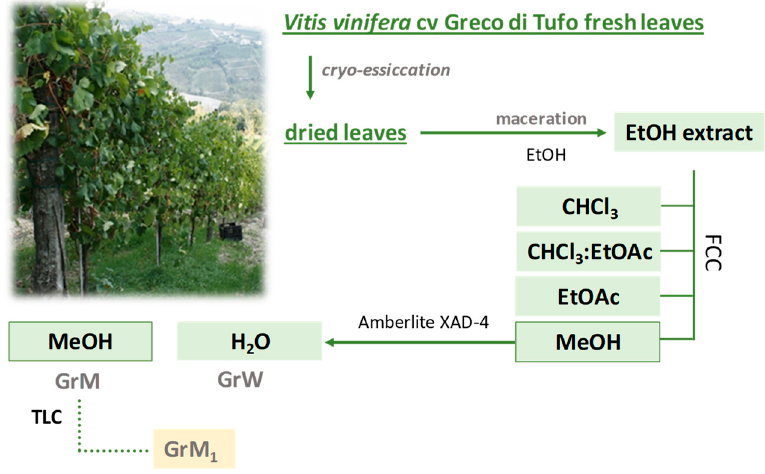
Figure 13. Extraction and fractionation scheme (FCC = flash column chromatography; TLC = thin-layer chromatography).